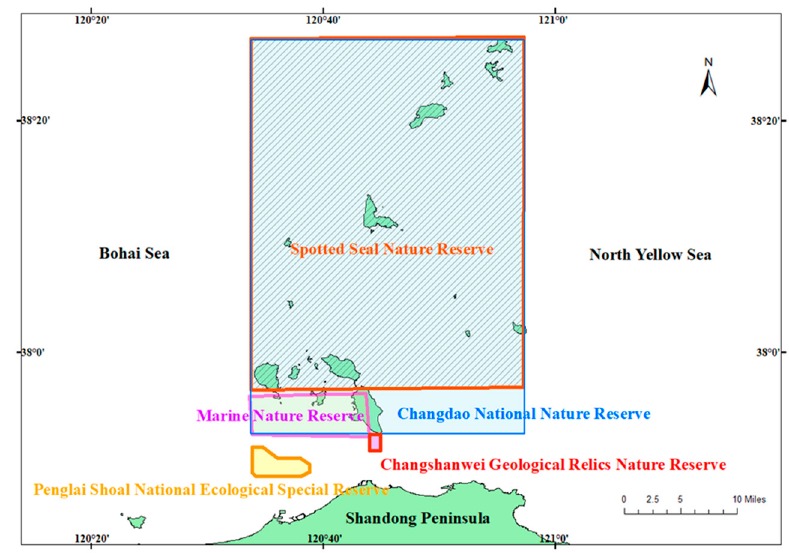
Figure 10. Schematic diagram of marine reserves in Miaodao Archipelago.